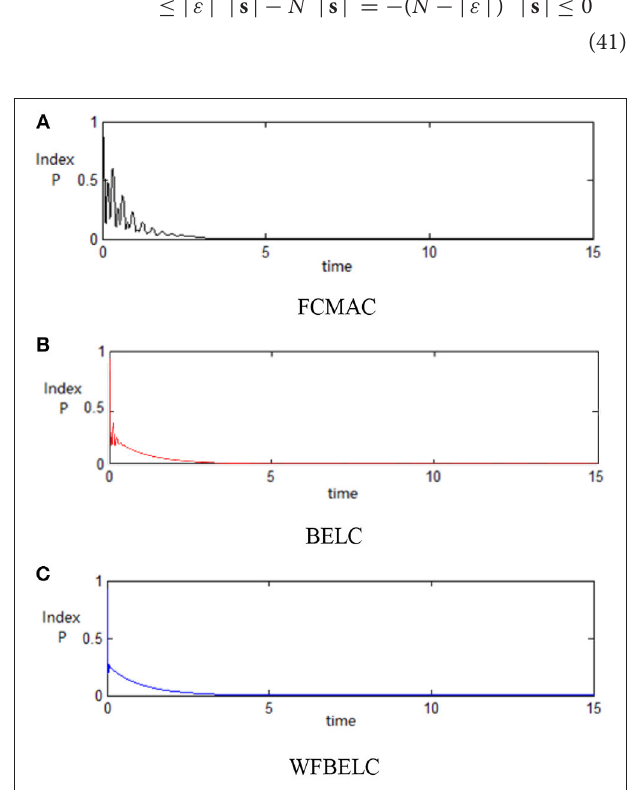
FIGURE 7 | Change trend chart of the control signal u ( q = 0.3) (A) FCMAC, (B) BELC, and (C) WFBELC.